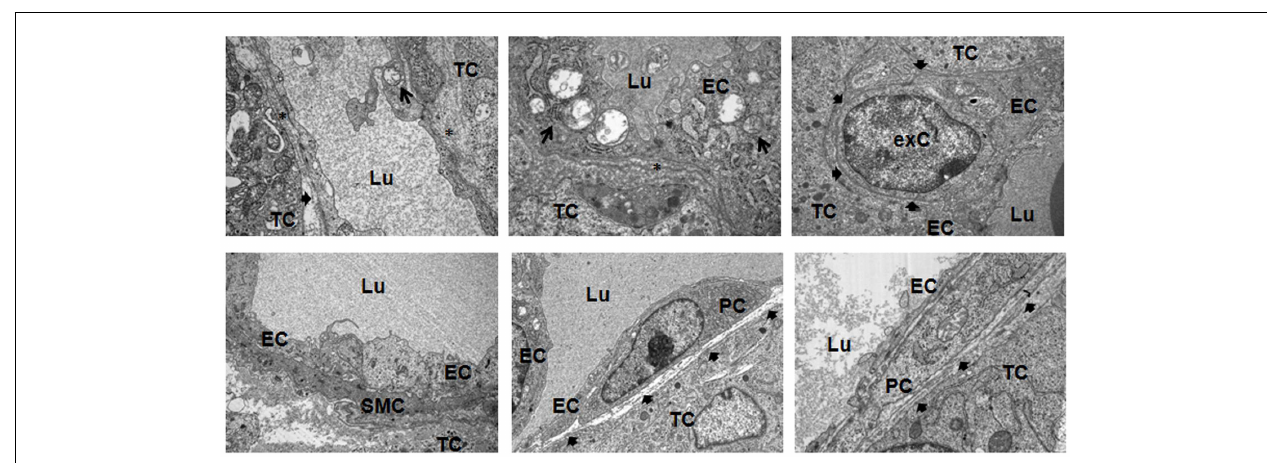
is emphasized by an asterix (*), a regular bMem assembly is depicted by a bold arrowhead. Arrows highlight partially degraded mitochondria in EC. PC, pericyte; SMC, smooth muscle cell;TC, tumor-cell; exC, extravasated cell; Lu, lumen. Representative images of three independent experiments are